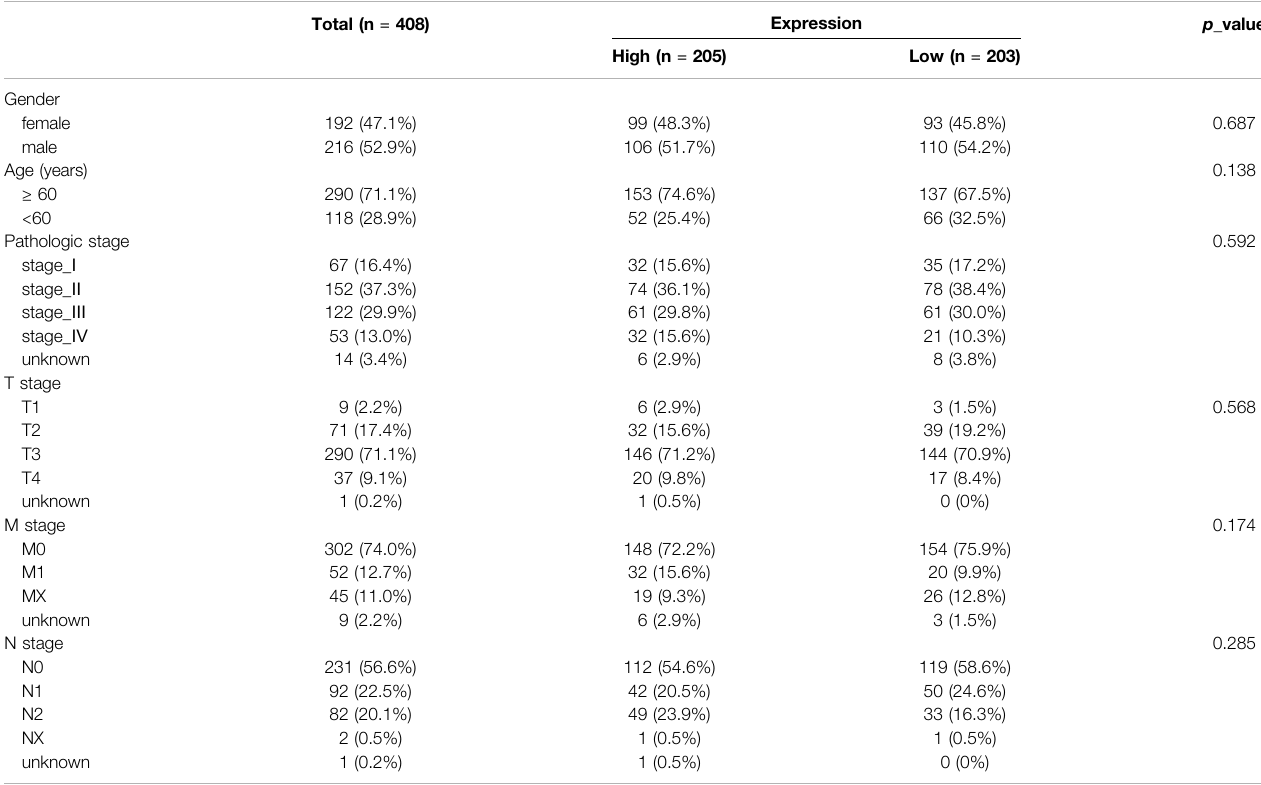
TABLE 1 | The relationship of CRC patients clinical feature and the DE-FLs